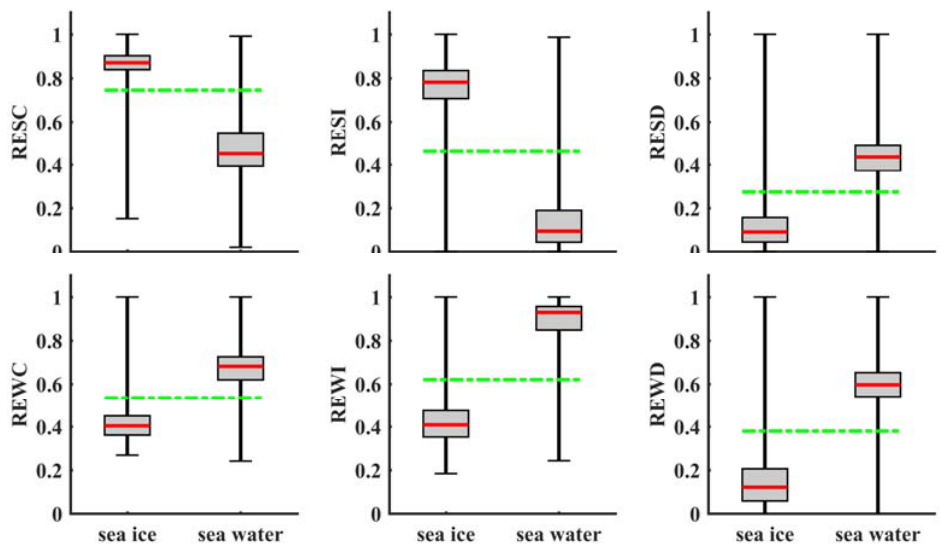
Figure 6. Box plots of six features (i.e., RESC, RESI, RESD, REWC, REWI and REWD) over sea ice and water using the data collected over the Arctic region from January 2015 to December 2018. The vertical height of the boxes indicates the interquartile range of the samples. While the parallel line (red) inside the boxes represents the median value of the samples for each parameter, the dotted line (green) represents the threshold obtained by the method proposed in [28] for distinguishing sea ice from water.